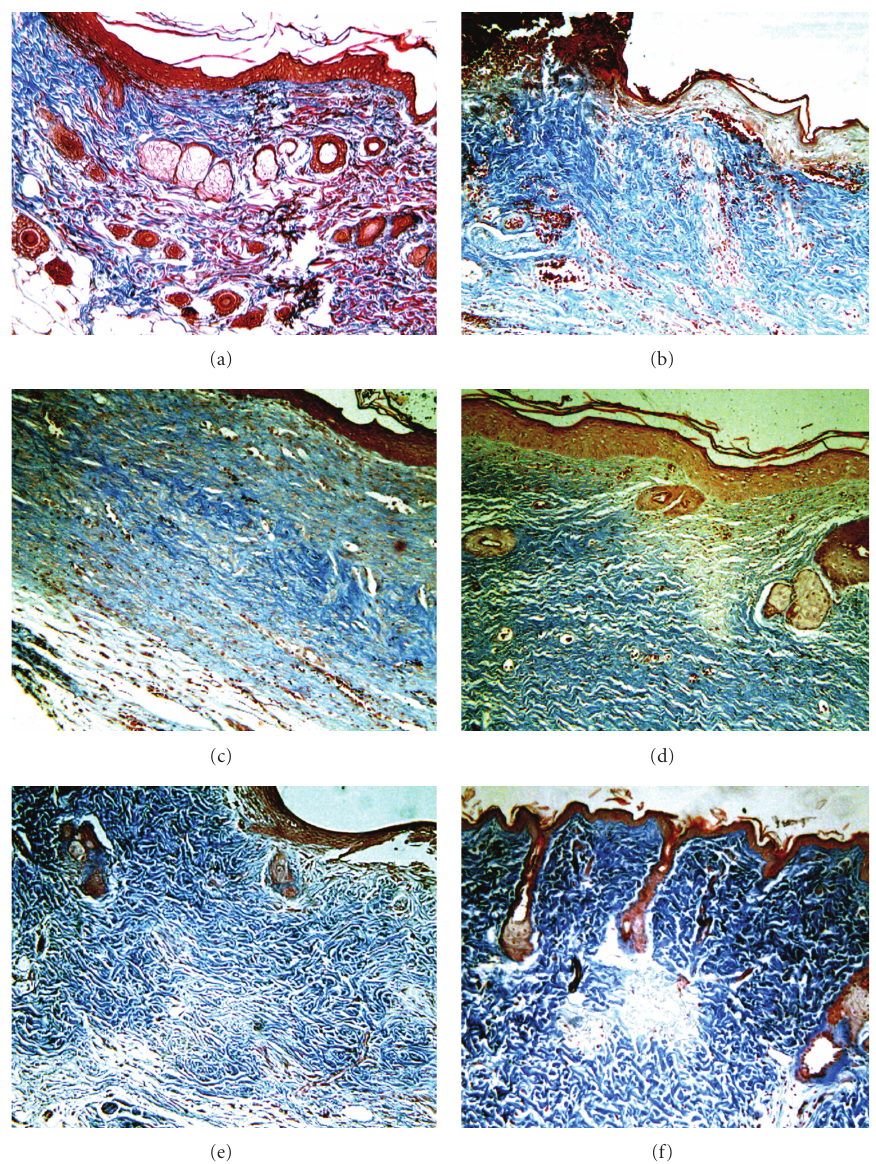
Figure 5: Epithelial tissue of rats in group 1 subjected to second-degree thermal burns. Masson’s trichrome staining. 100x Magnification. (a) Normal epithelial tissue with all skin appendages. (b) Animal presenting epithelial tissue with complete destruction of the dermis and epidermis showing exudates albumin/leukocyte/macrophage intense, necrosis, edema, and crust at the 7th day after injury induction. (c) Animal at the 14th day with tissue reepithelialization, moderate autolysis, moderate exudate albumin/leukocyte/macrophage, intense neovascularization, and discrete fibroblast proliferation with the presence of loose collagen and mild fibrosis. (d) Animal at the 21st day with incomplete tissue reepithelialization, mild exudate albumin/leukocyte/macrophage, moderate neovascularization, intense fibroblastic proliferation, and presence of dense collagen, not modeled and moderate fibrosis. (e) Animal at the 28th day with complete tissue epithelialization, exudate albumin/leukocyte/macrophage discrete in the epidermis, moderate fibroblastic proliferation, presence of modeled dense collagen mesh and moderate fibrosis. (f) Animal at the 35th day with complete reepithelialization, mild fibroblastic proliferation, and presence of modeled dense collagen mesh and moderate